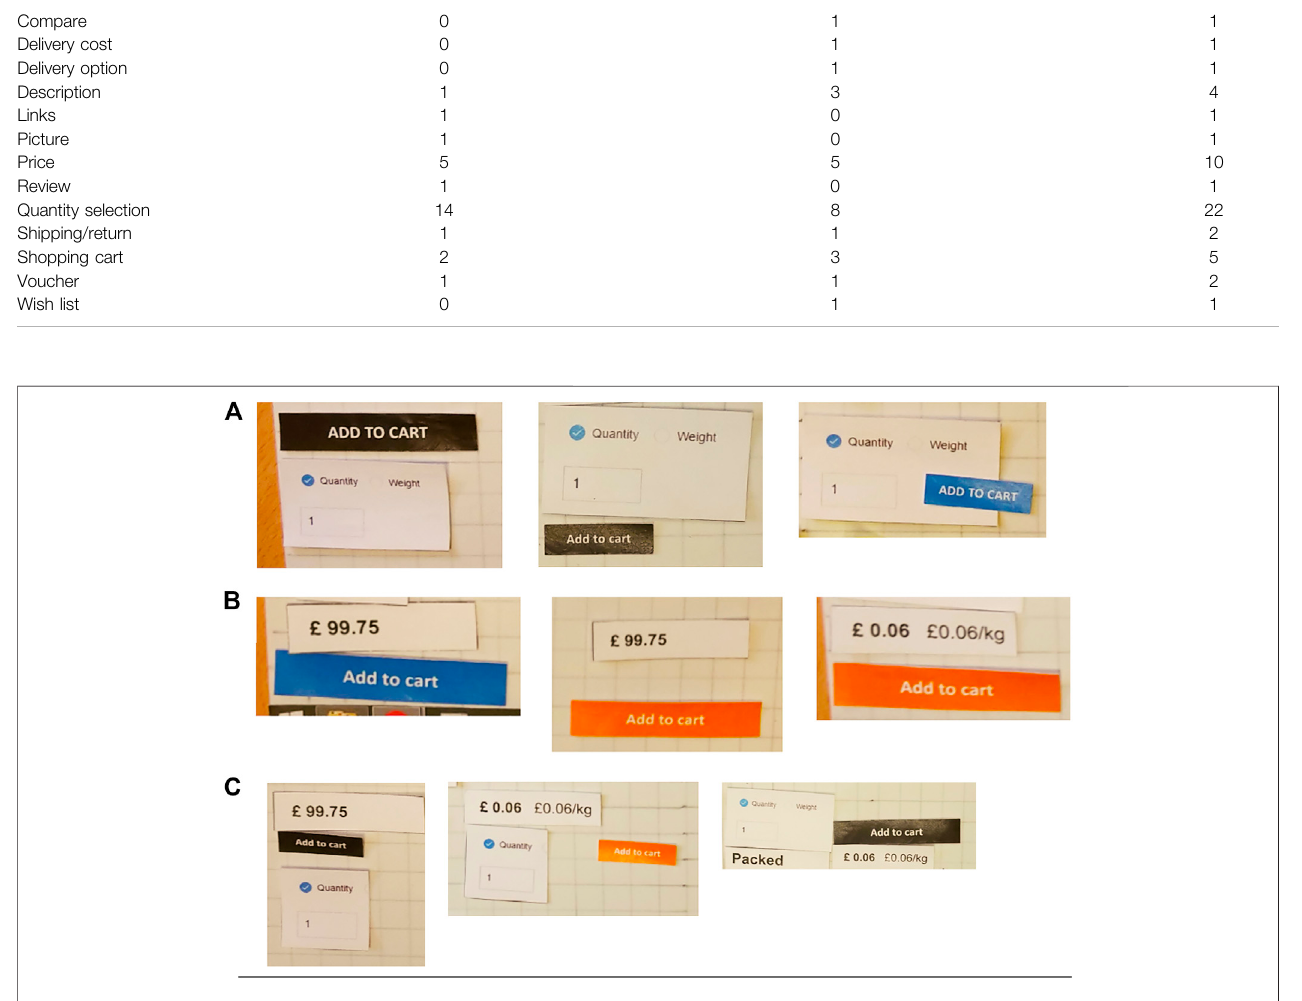
FIGURE 7 | Examples of the location of “ add to cart ” buttons, relative to the quantity selection and price objects. (A) Close to quantity selection, (B) close to price, and (C) close to both price and quantity selection. Note that “ close to ” is de fi ned as being within two grid squares.